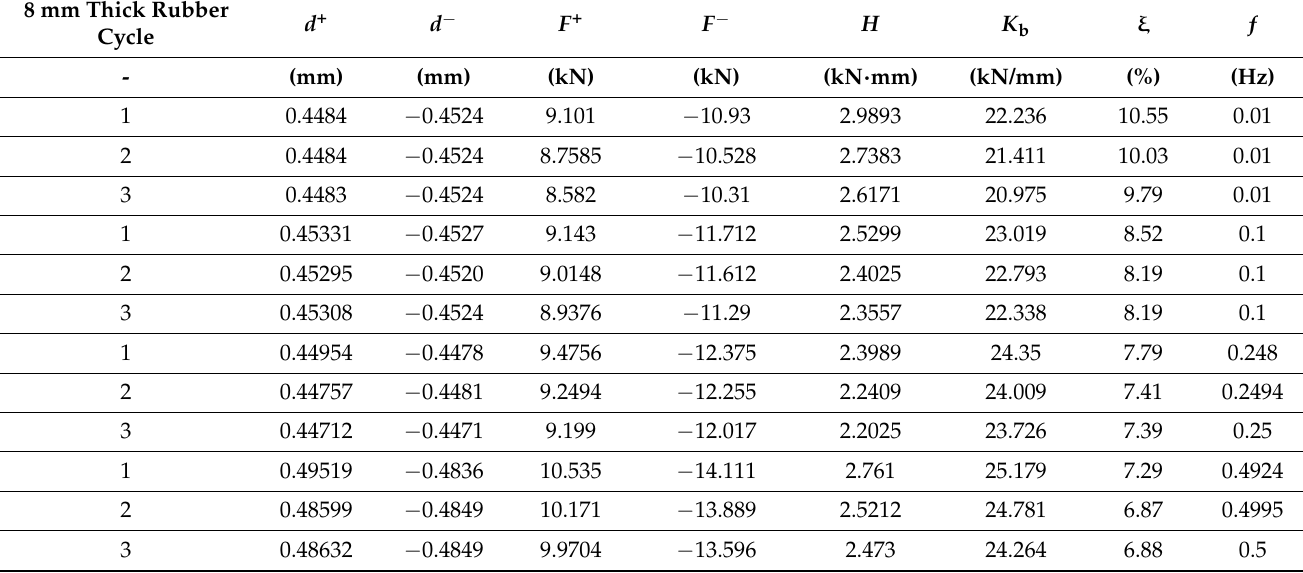
Figure 9. Plot of device testing, showing force–displacement for 8 mm thick HDR material at different frequencies. Table 5. Result data for 8 mm thick HDR material at different frequencies .